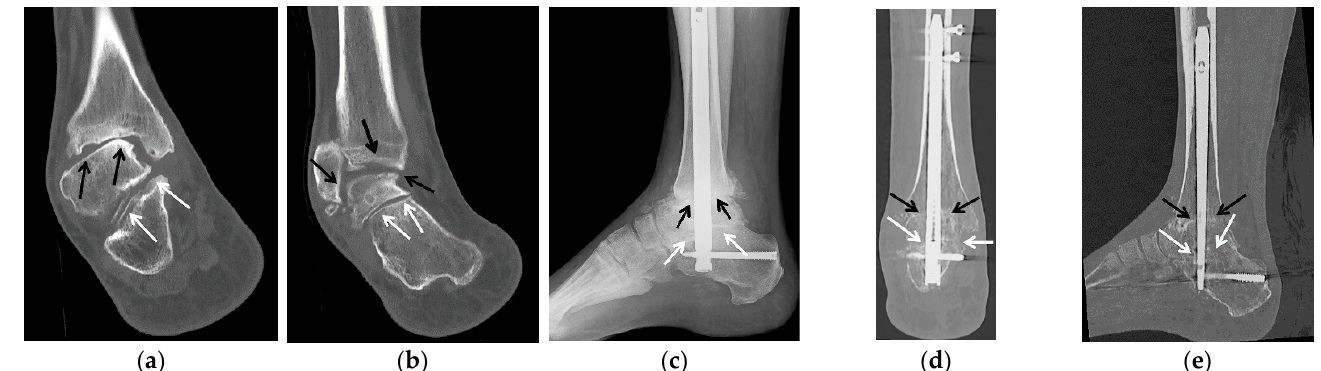
Figure 3. ( a – e ) A 58-year-old male with tibiotalar and subtalar osteoarthritis with varus alignment treated with tibiotalocalcaneal arthrodesis with intramedullary nail and iliac crest bone marrow aspirate. ( a , b ) Coronal reformatted preoperative CT images of the right ankle show advanced osteoarthritis of the tibiotalar (black arrows) and posterior subtalar (white arrows) joints with associated varus deformity. ( c ) Six weeks postoperative lateral weight-bearing radiograph shows a retrograde tibiotalocalcaneal intramedullary nail with interlocking screws in the calcaneus and distal tibial diaphysis transfixing the subtalar (white arrows) and tibiotalar (black arrows) joints with associated bone graft material. ( d ) Coronal and ( e ) sagittal reformatted CT images obtained 2.5 months after surgery show markedly improved alignment with progressive fusion across the subtalar (white arrows) and tibiotalar (black arrows) joints.